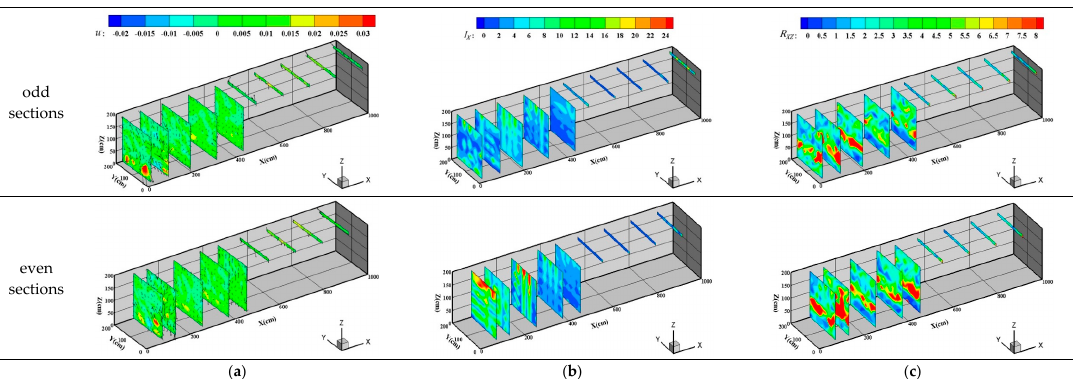
Figure 4. Distribution of longitudinal flow characteristics: ( a ) velocity (the contour plot represents the longitudinal velocity u , and the vector represents velocity v - w ); ( b ) dimensionless turbulence intensity 𝐼 (cid:3025) ; and ( c ) dimensionless Reynolds shear stress 𝑅 (cid:3025)(cid:3027) (The unit of velocity is m/s, and the dimensionless turbulence intensity and dimensionless Reynolds shear stress is dimensionless).